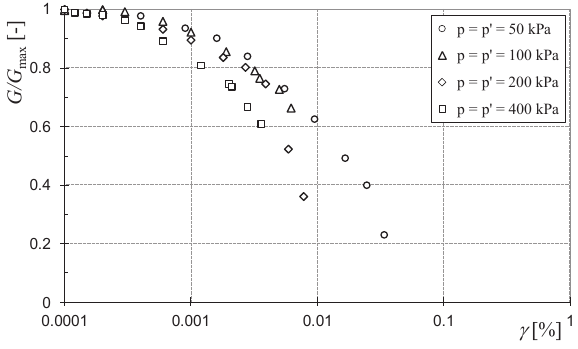
Figure 7: The results of the RC tests for sample S3935. Fig. 7. The results of the RC tests for sample S3935.